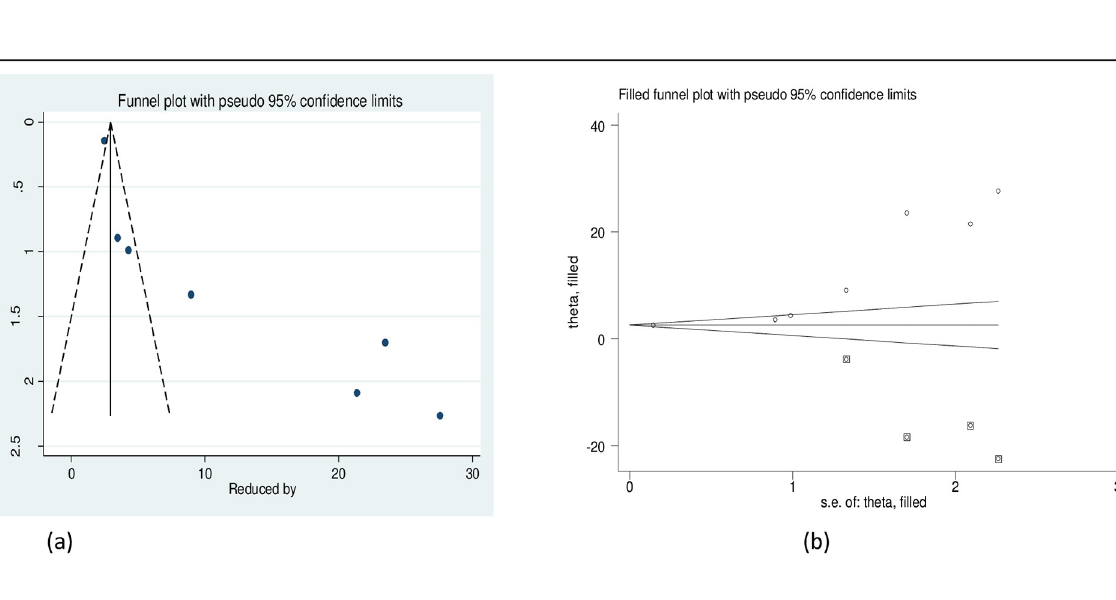
PLOS ONE | https://doi.org/10.1371/journal.pone.0281260 February 7,